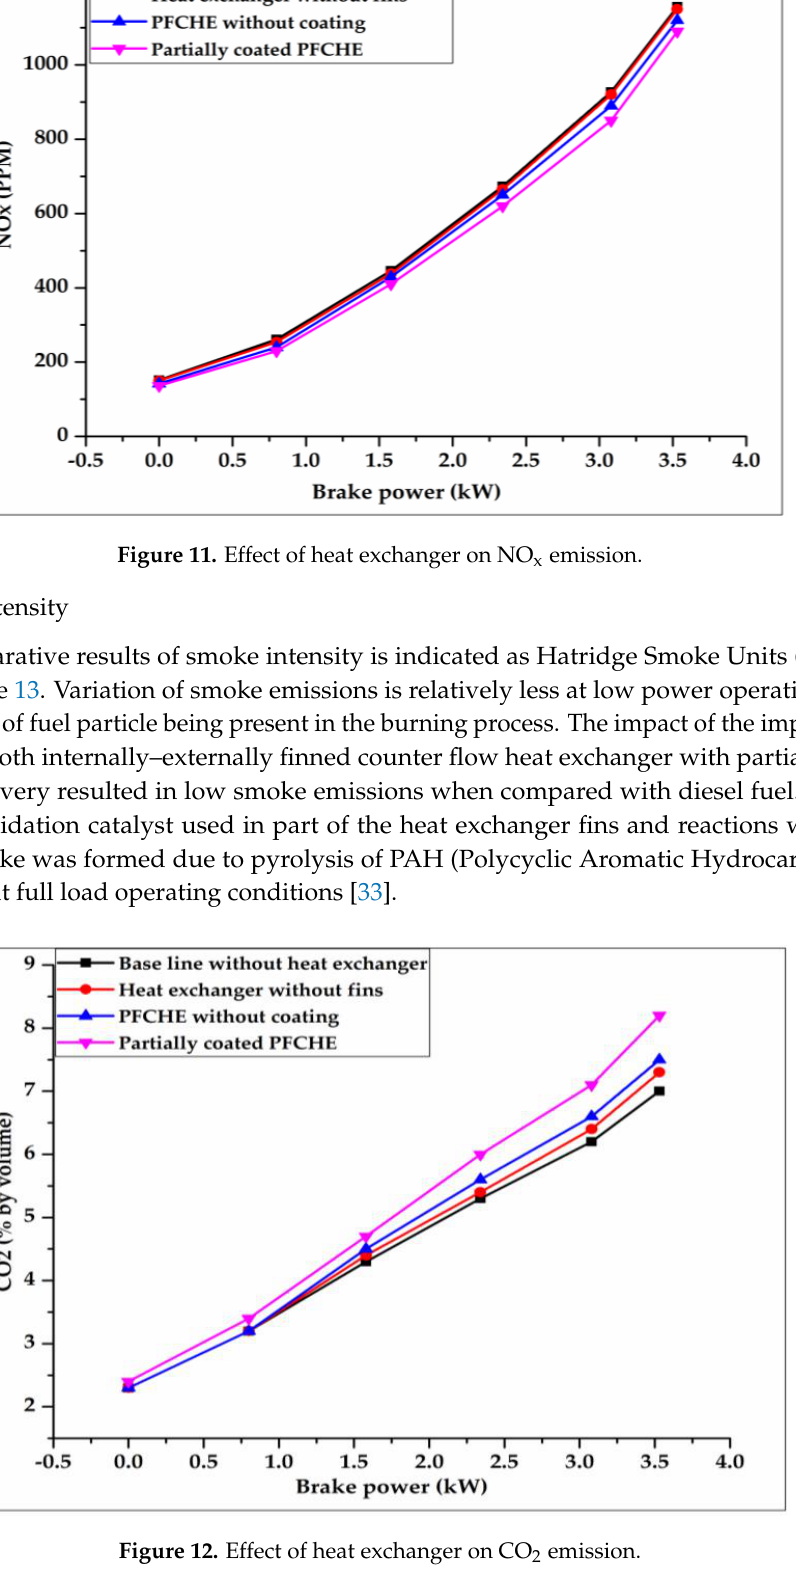
Figure 10. Effect of heat exchanger on CO emission.